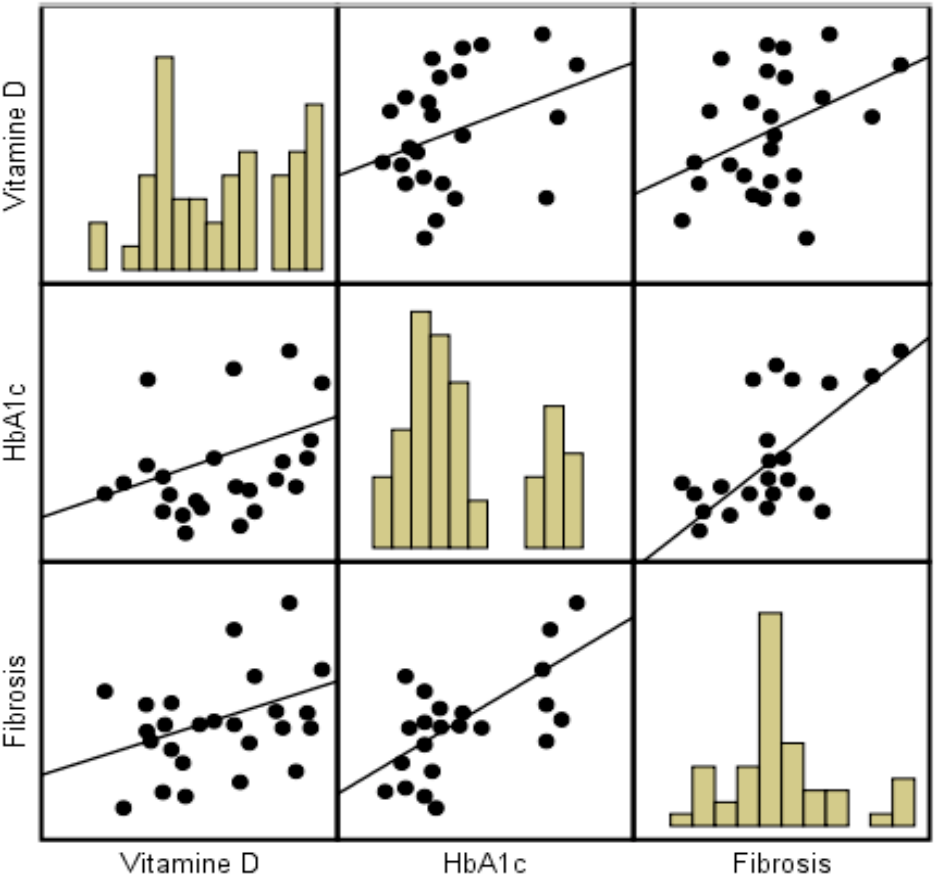
Figure 2. Correlation between vitamin D (ng/dL), Hba1c, and fibrosis.